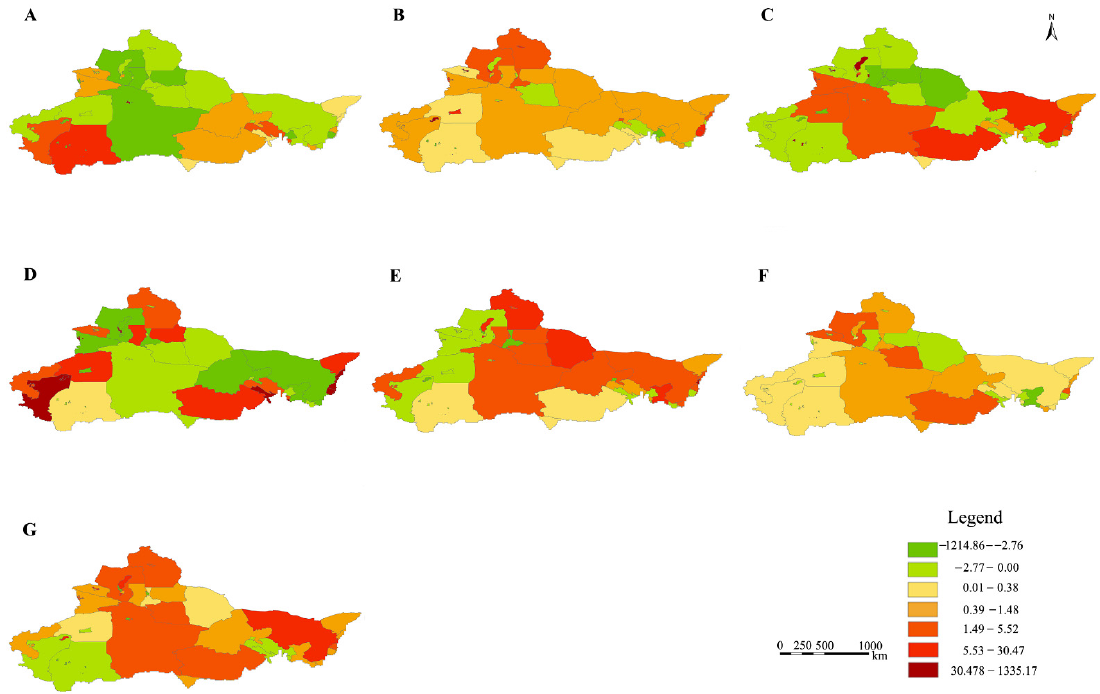
Figure 5. Relative dynamic degree of waters in the arid desert region of Northwest China, ( A ) 1990–1995, ( B ) 1995–2000, ( C ) 2000–2005, ( D ) 2005–2010, ( E ) 2010–2015, ( F ) 2015–2020, ( G ) 1990– 2020.